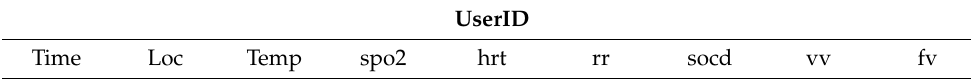
Table 2. Data collection metrics for a specific user.